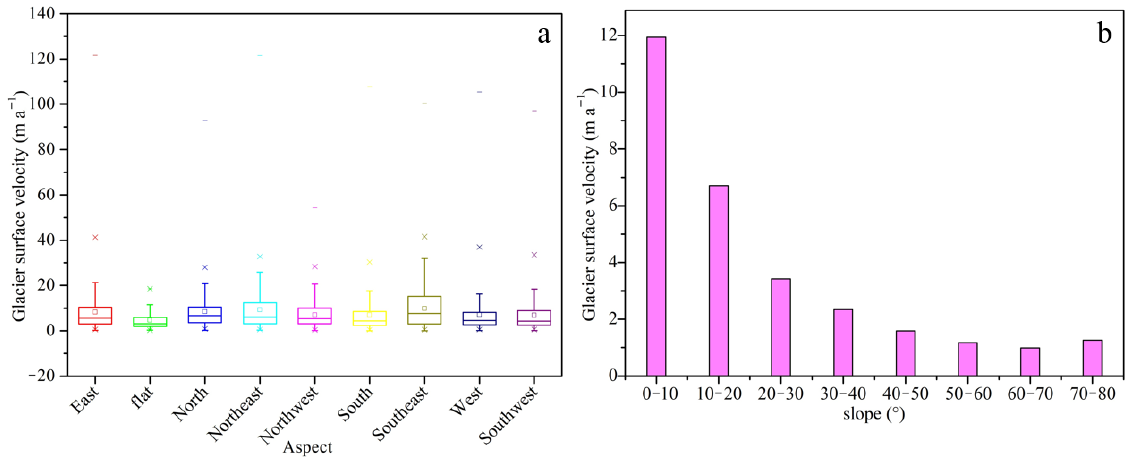
Figure 8. Influence of aspect and slope on glacier flow rate in the Tomur peak region, 2000–2020 ( a , b